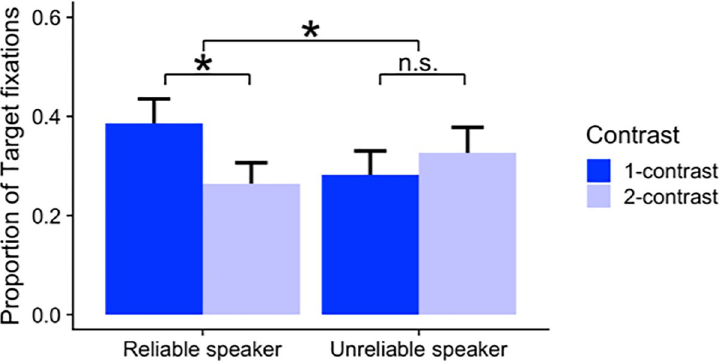
Fig 3. Time course of target fixations during instructions (e.g., Click on the large cup) in the unreliable-speaker condition with only bottom-up information (Experiment 2). The 1- and 2-contrast conditions are plotted in the left and right panels, respectively. Vertical lines indicate the mean 1) adjective onset (aligned to 0), 2) adjective offset, and 3) noun offset. Shaded area indicates the 500ms planned analysis window.